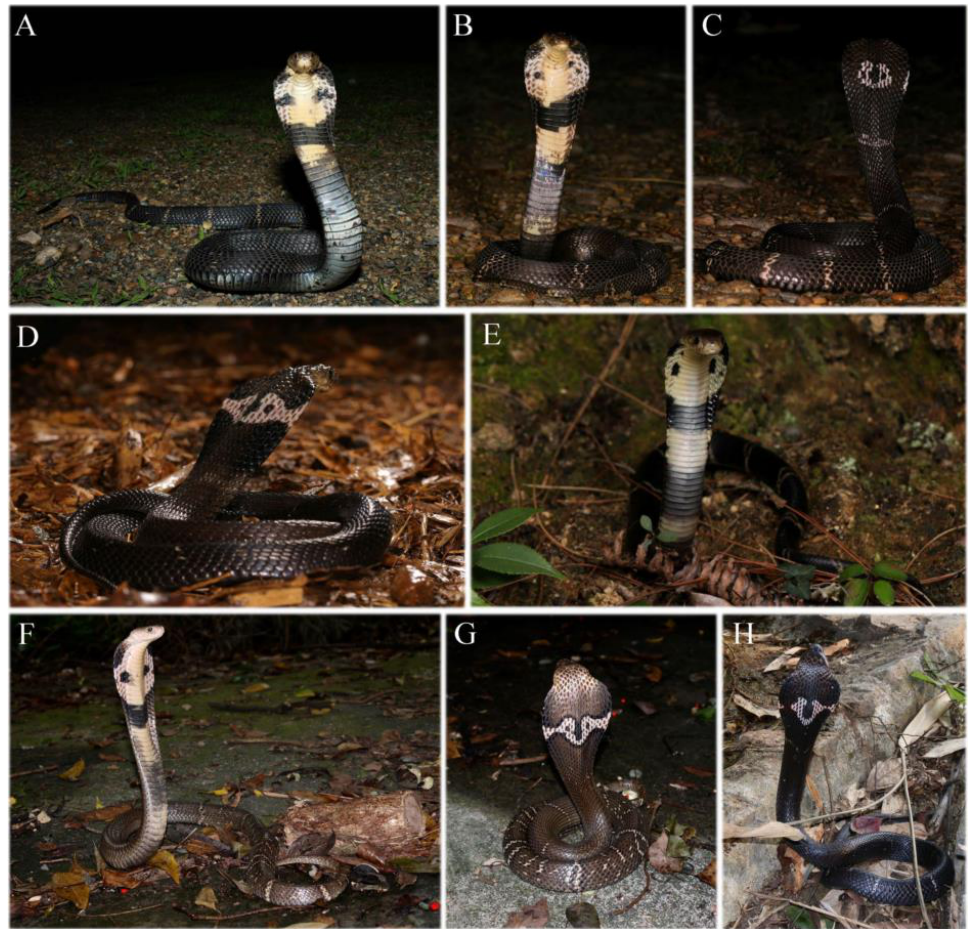
Figure 5. Naja atra in life. ( A ) Adult from Qingtian, Zhejiang, China; ( B – D ) one adult ( B , C ) and another ( D ) from Lishui, Zhejiang, China; ( E ) juvenile from Wuyi, Fujian, China; ( F , G ) one adult from Guangzhou, Guangdong, China; ( H ) adult from Guangzhou, Guangdong, China. ( A – E ) Pho- tographed by Bin-Qing Zhu; ( F – H ) photographed by Liang Zhang.